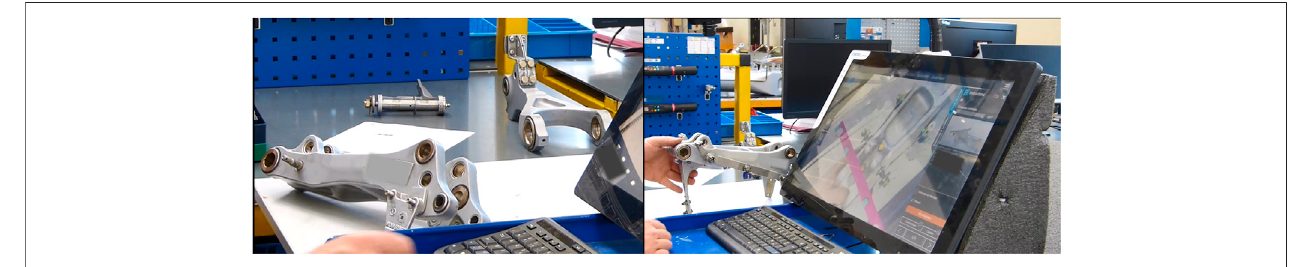
FIGURE 2 | Pictures of the equipment, AR app, and AR workstation used in the study for experimentation in the work environment.